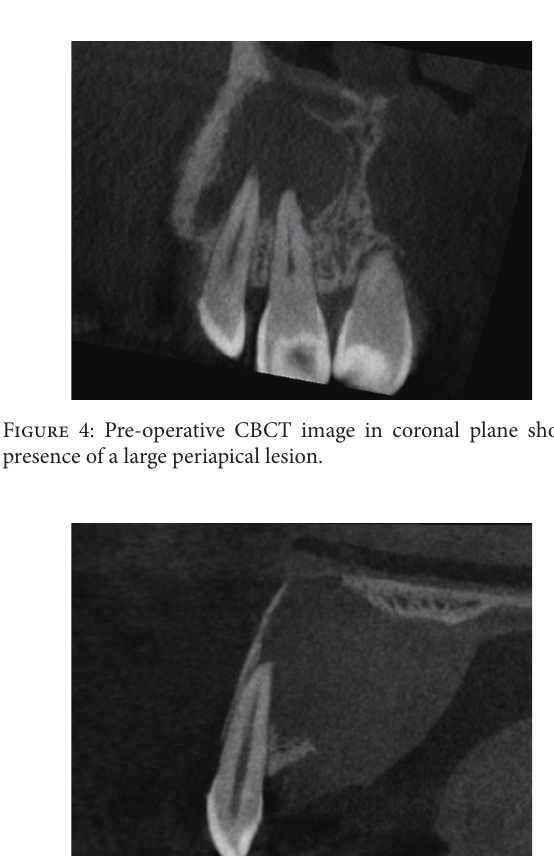
Figure 2: Pre-operative photo showing swelling of the palatal soft tissue.